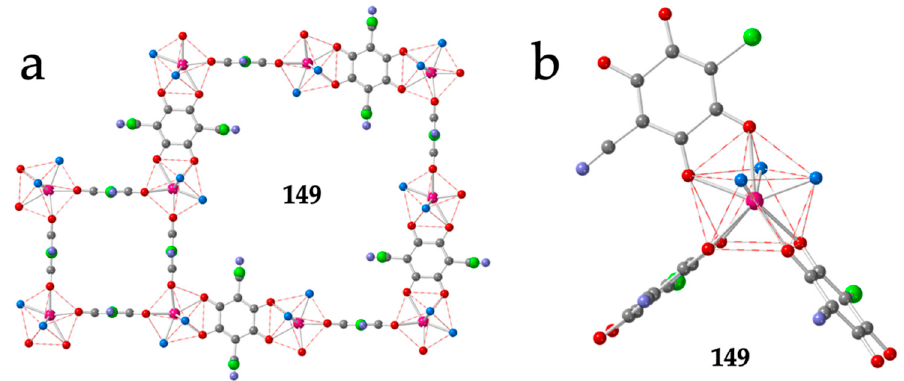
Figure 17. ( a ) View of a four ‐ membered ring and an eight membered ring of the (3,4)+(3,8) layer in compound 149 . ( b ) SCAPR ‐ 9 Coordination environment of the Er(III) ions in compound 149 showing the orthogonal orientation of the three anilato bridges. Colour code: Ln = pink, C = grey, Cl = green, N = light blue, O anilato = red and O solvent = blue.